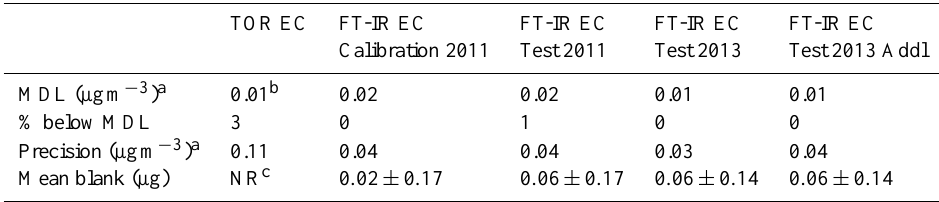
Table 4. MDL and precision for FT-IR EC and TOR EC.